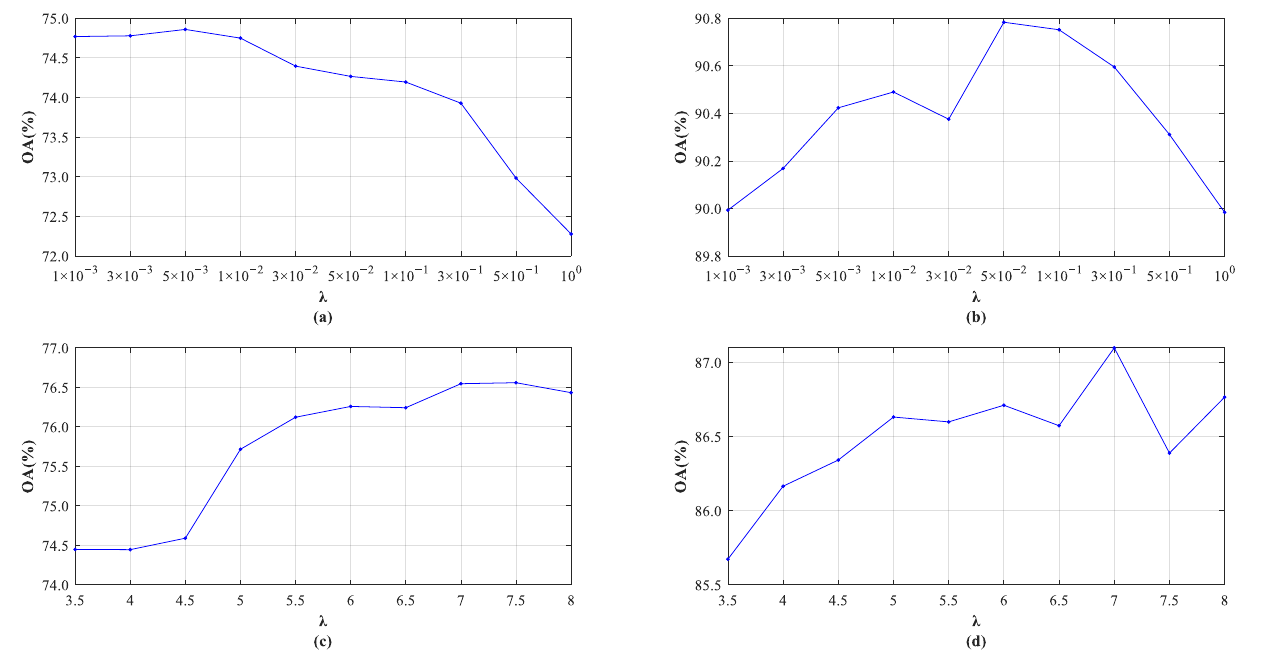
Figure 2. Classification performance for ( a ) CRC, ( b ) CRT, ( c ) NSC, and ( d ) NRS under different values. λ